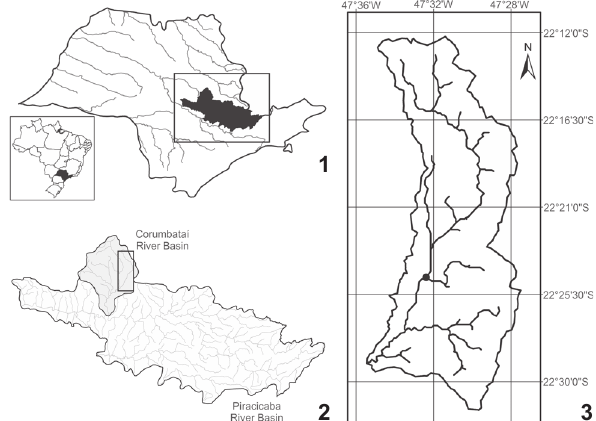
Figures 1-3. Location of studied area: (1) Piracicaba River Basin in State of São Paulo; (2) Ribeirão Claro stream ( (cid:133) ) in Corumbataí River Basin; (3) Ribeirão Claro Basin with indication of studied area